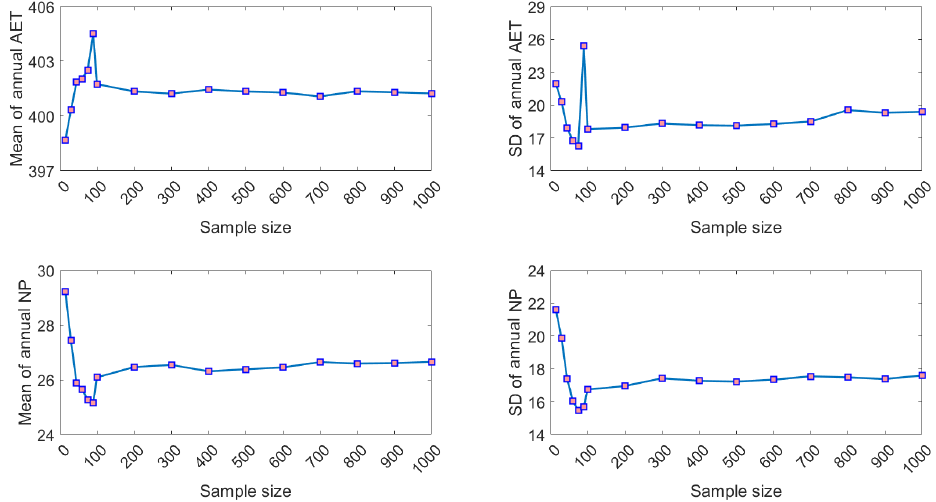
Figure A2. Mean and SD values of the annual AET and NP corresponding to each sample